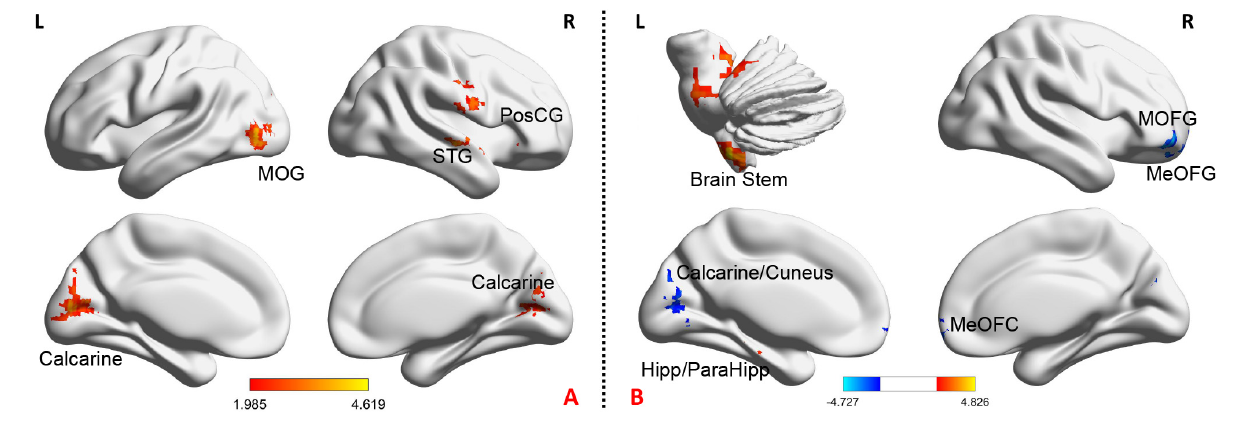
FIGURE 2 | The baseline and the change of fALFF after treatment in CSAP patients. (A) Illustrates the baseline comparison of fALFF between CSAP patients and HS. The warm tone indicates CSAP patients > HS. (B) Illustrates acupuncture effects on the fALFF of CSAP patients. The warm tone indicates increased fALFF after treatment while the cool tone indicates decreased fALFF after treatment. Threshold: voxel-level p < 0.05, cluster-level p-GRF < 0.05. MOG, middle occipital gyrus; PosCG, postcentral gyrus; STG, superior temporal gyrus; MOFG, middle orbitofrontal gyrus; MeOFG, median orbitofrontal gyrus; ParaHipp, parahippocampus; Hipp, hippocampus; L, left; R,